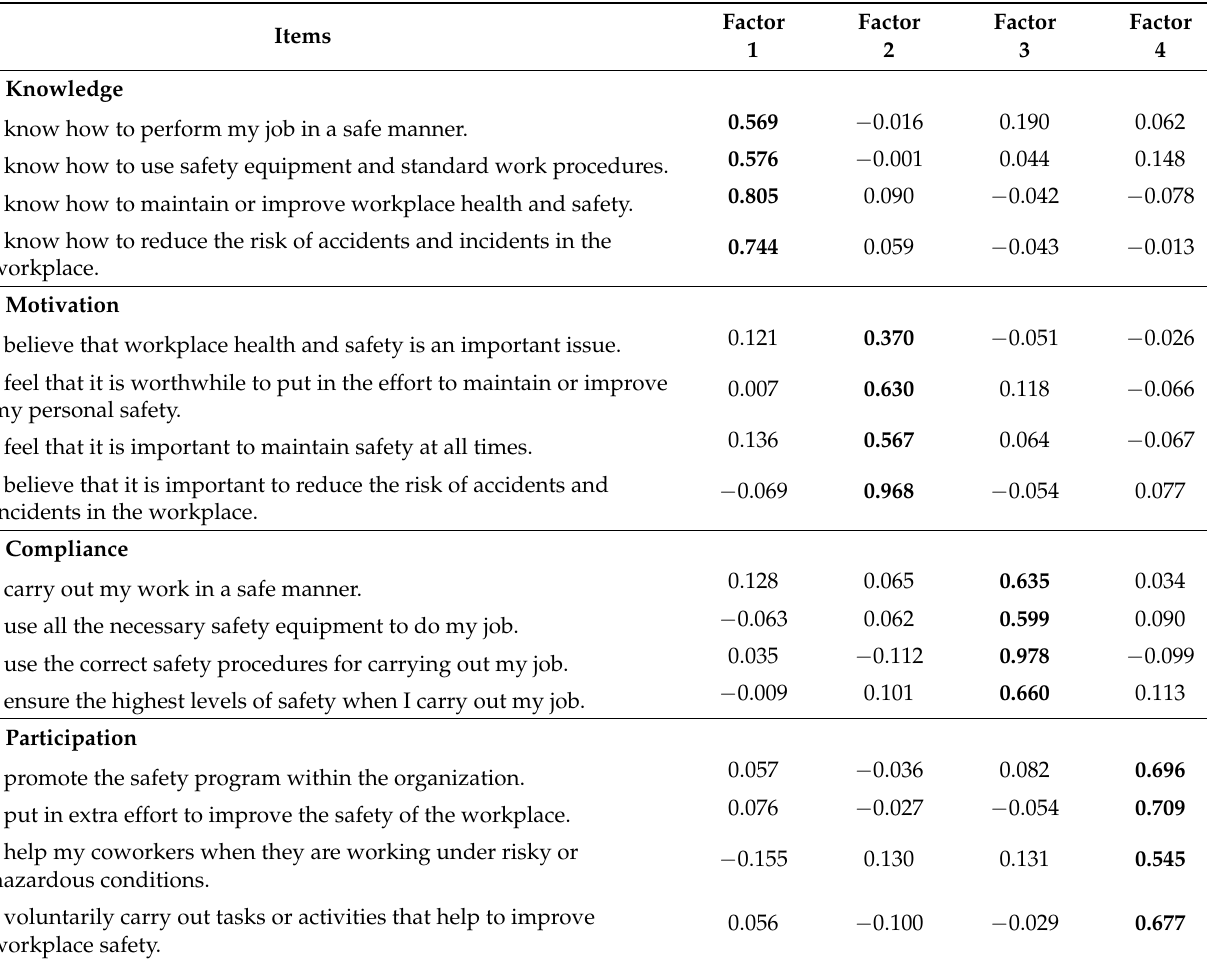
Table 4. Results of exploratory factor analyses for the WHASI-G (rotated solution).